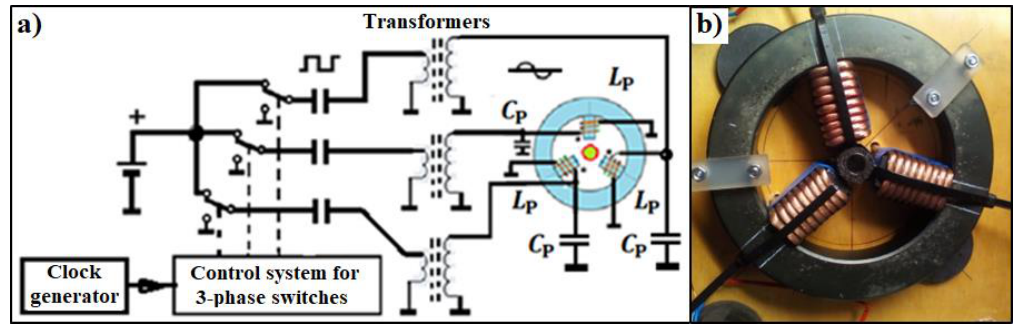
Figure 1. Diagram of a system for generating of rotating magnetic field of high frequency ( a ) and elements of the magnetic circuit: ferrite torus, 3 coils on ferrite cores ( b ).